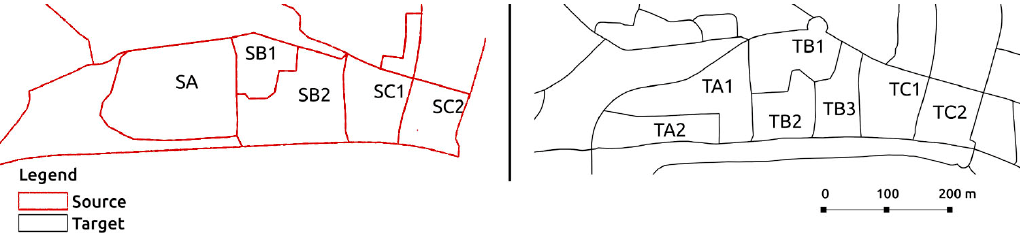
Figure 2. Census tracts: Source (Geographic Base for Information Referencing—BGRI 2001) and target (BGRI 2011).